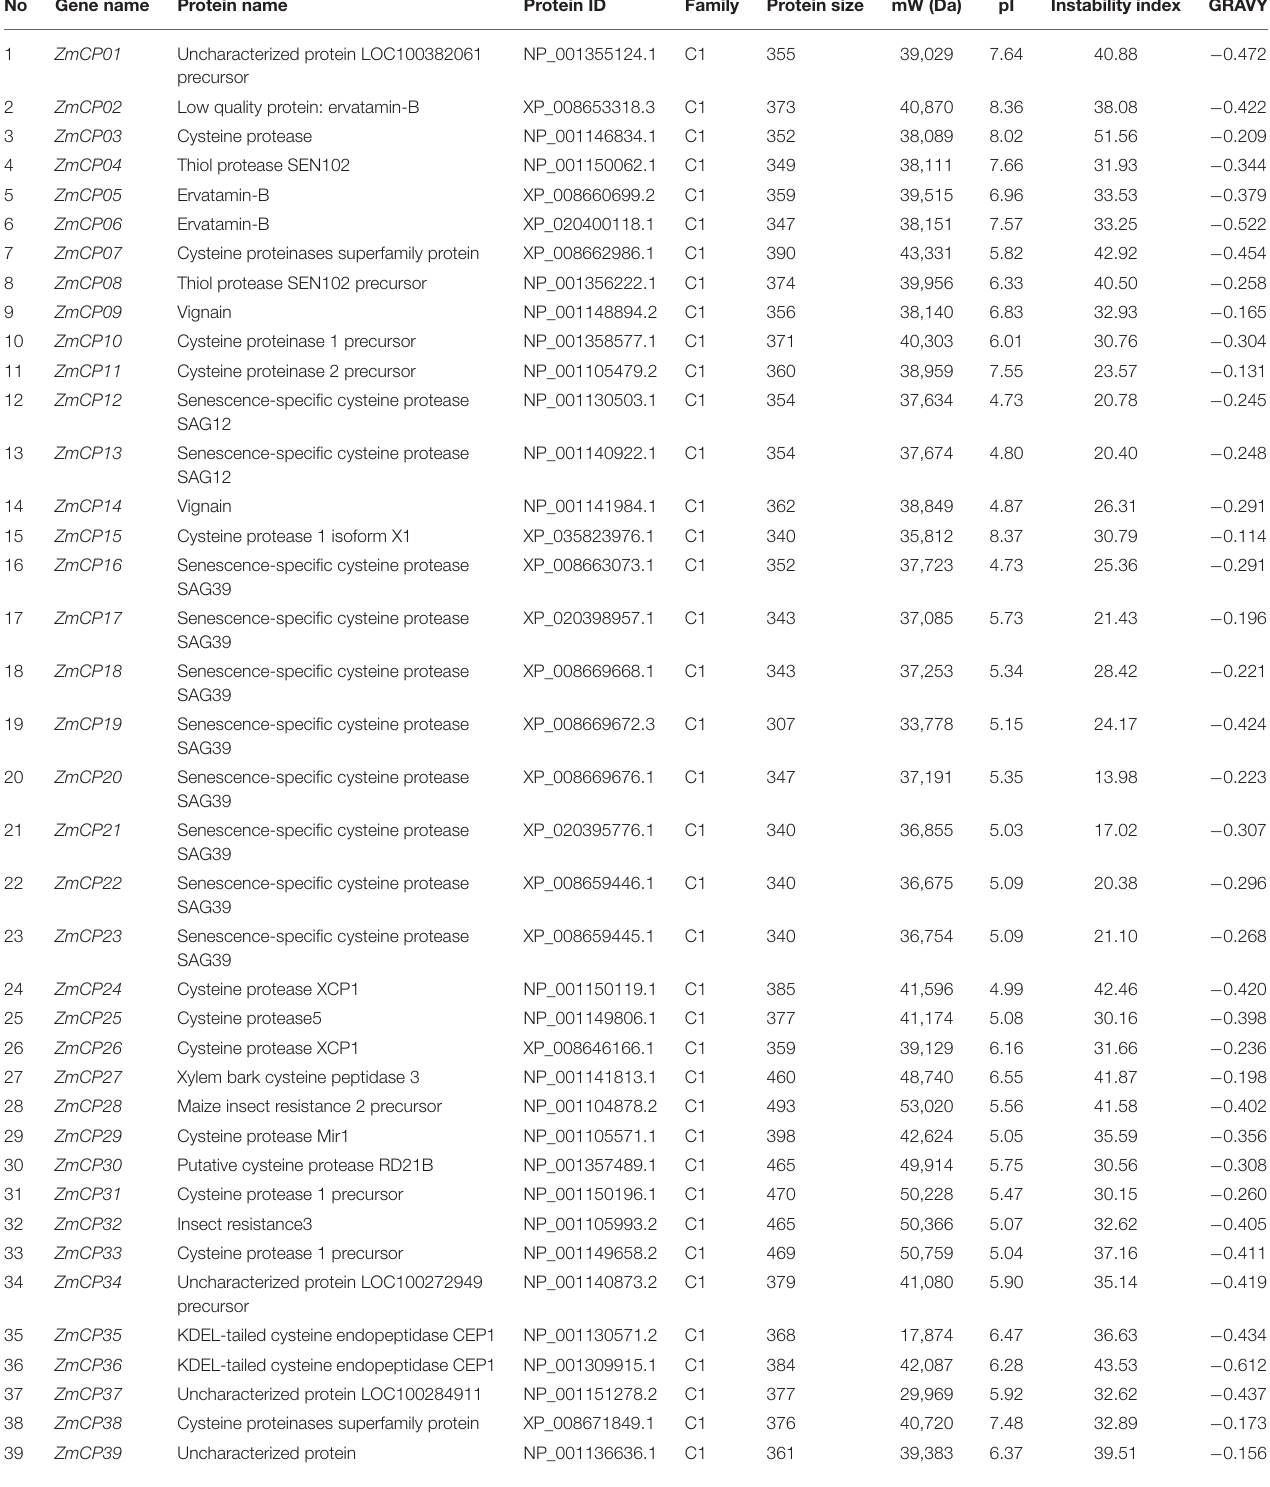
TABLE 1 | Physiochemical properties of the identified ZmCP proteins in